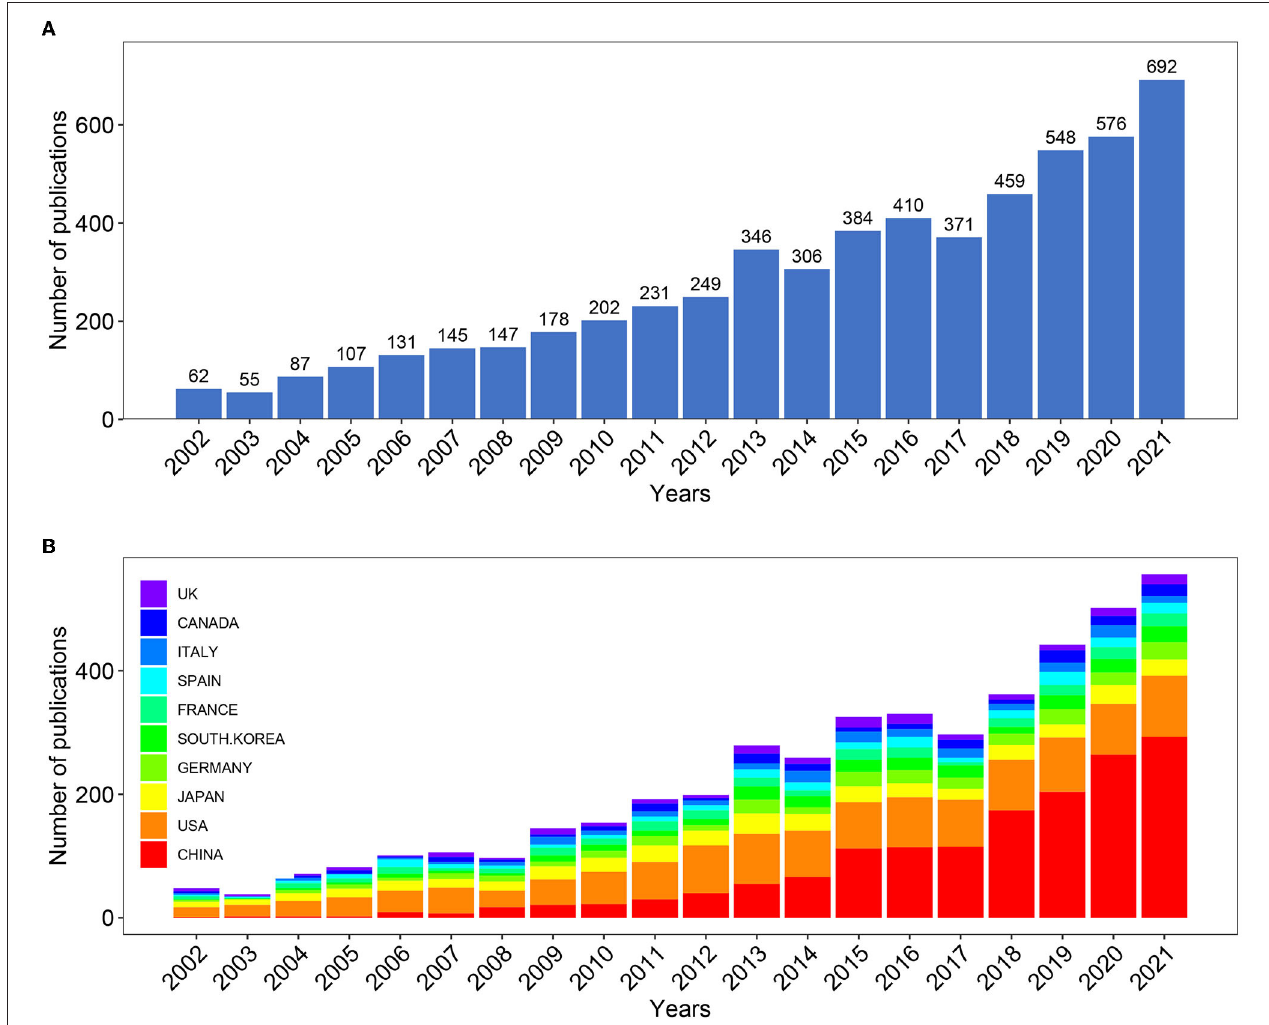
FIGURE 2 | (A) Number of annual research publications and growth trends on the topic of hepatic glycolipid metabolism from 2002 to 2021, export of results from Web of Sciences. (B) Number of annual research publications and growth trends on the topic of hepatic glycolipid metabolism from 2002 to 2022, export of results from the Online Analysis Platform of Literature